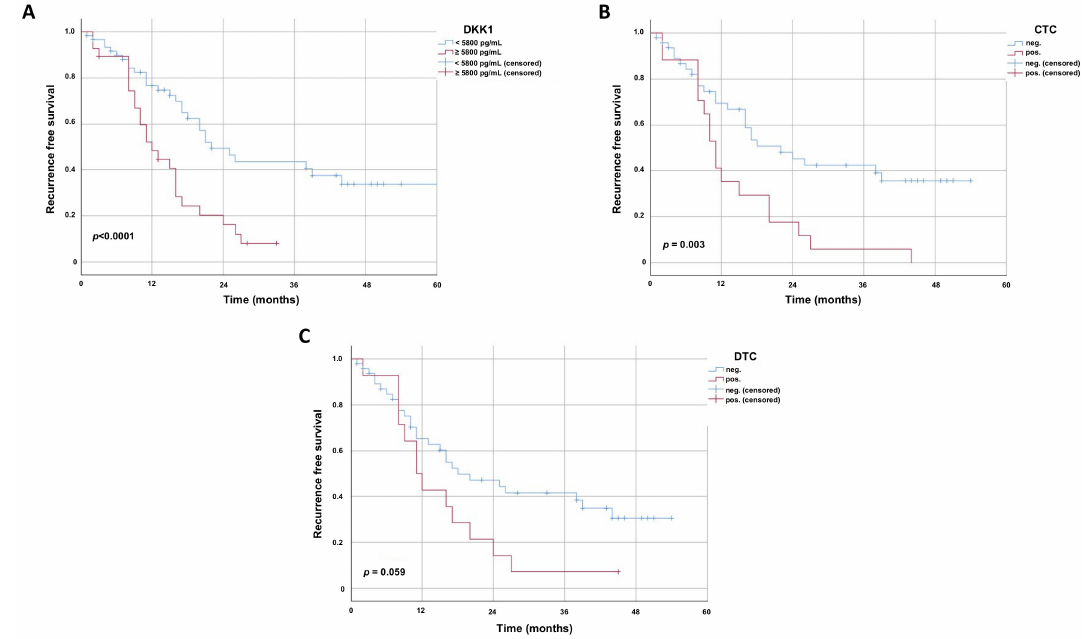
Figure 2. Kaplan–Meier survival curves displaying time to recurrence in 91 esophageal cancer patients. Kaplan–Meier survival curves displaying time to recurrence in months of esophageal cancer patients ( n = 91). Univariate analysis was carried out by the logrank test (Mantel–Cox). A p -value < 0.05 was considered as statistically significant. Patients who were lost during follow up were censored at their last documented visit. ( A ) Time to recurrence of esophageal cancer patients with respect to S-DKK1 levels. Subgroups were built based on the mean values of all S-DKK1 levels in the 91 esophageal cancer patients. ( B ) Time to recurrence of esophageal cancer patients with respect to the presence of CTCs in the blood. A cut-off value of at least one CTC was used to define the presence of CTCs. ( C ) Time to recurrence of esophageal cancer patients with respect to the presence of DTCs in the blood. A cut off value of at least one DTC was used to define the presence of DTCs. Table 4. Univariate analysis of cancer recurrence in esophageal cancer patients with respect to S-DKK1, presence of CTCs and DTC